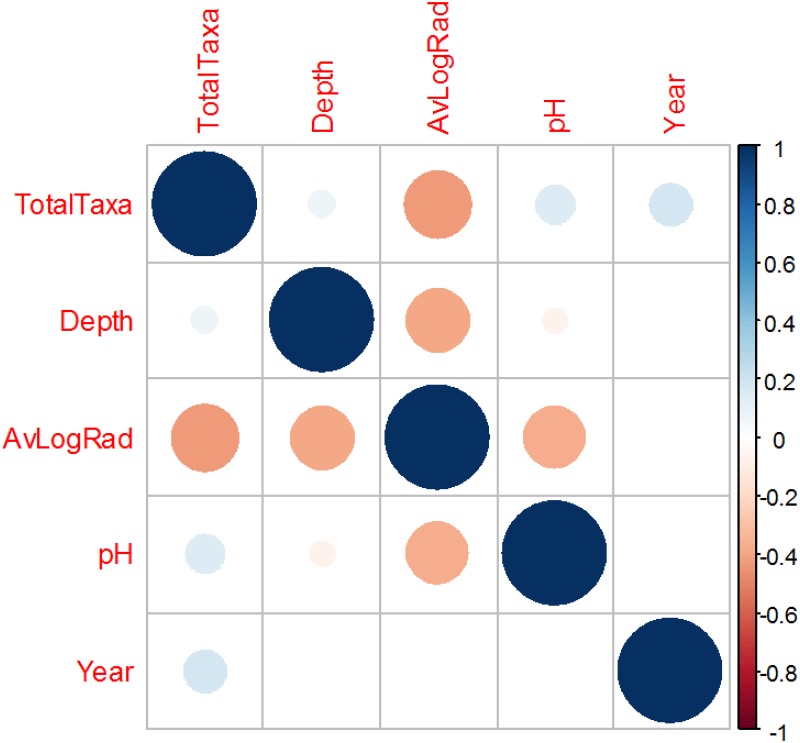
Graphical representation of Pearson correlations between numerical variables in data set I (fungi at Chernobyl).